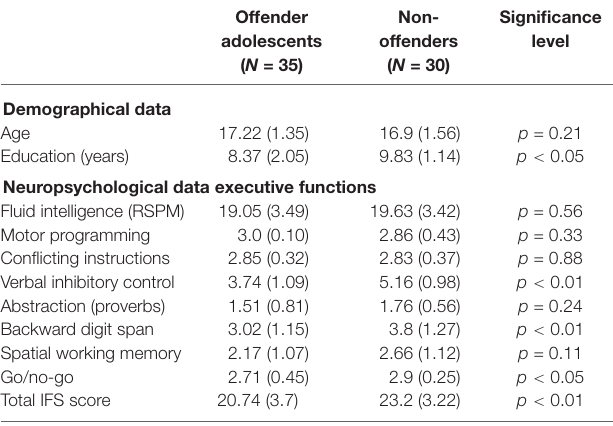
TABLE 1 | Demographical and neuropsychological data comparison between offender adolescents (AOs) and non-offenders (NOs).